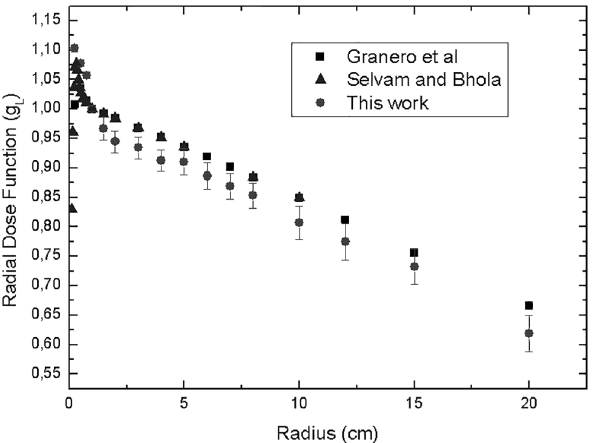
Fig 3. Comparison of the radial dose function in the source transversal axis, which was obtained for the BEBIG 60 Co HDR source using the cavity EGSnrc Monte Carlo code.